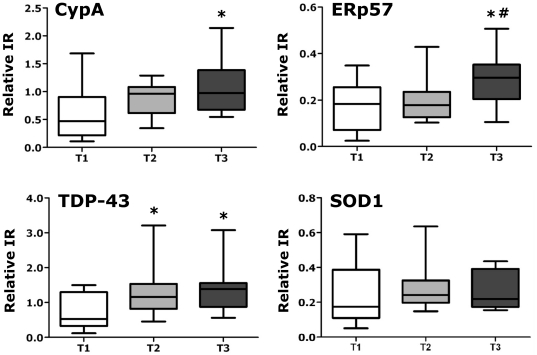
Longitudinal analysis of protein biomarkers CypA, ERp57 and TDP-43.Graphs show relative immunoreactivity (IR) for the indicated proteins measured by dot blot assay in PBMC of sALS patients (n = 13) over a period of six months. PBMC were collected at t = 0 (T1, white column), at t = 3 months (T2, grey column) and at t = 6 months (T3, black column). SOD1 was used as a negative control. Immunoreactivity was normalized to the actual amount of protein loaded, detected after Red Ponceau staining. Data are the means ± SEM of relative immunoreactivity. *, significantly different (p<0.05) from T1 as assessed by repeated measures ANOVA followed by Tukey's multiple comparison test; #, significantly different (p<0.05) from T2 as assessed by repeated measures ANOVA followed by Tukey's multiple comparison test.